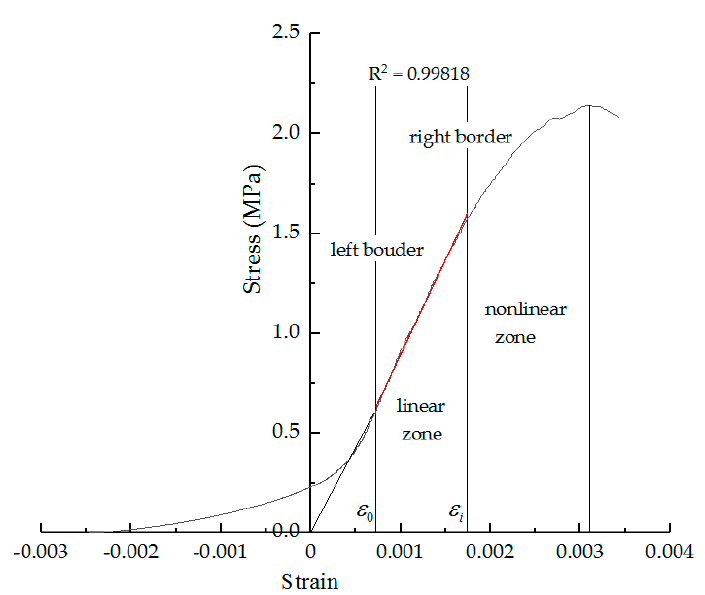
Figure 4. Linear zone and nonlinear zone in stress–strain curve.